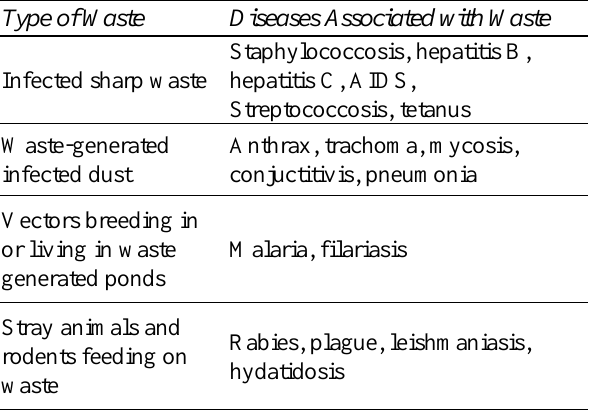
Table 4: Selected infectious diseases associated with solid